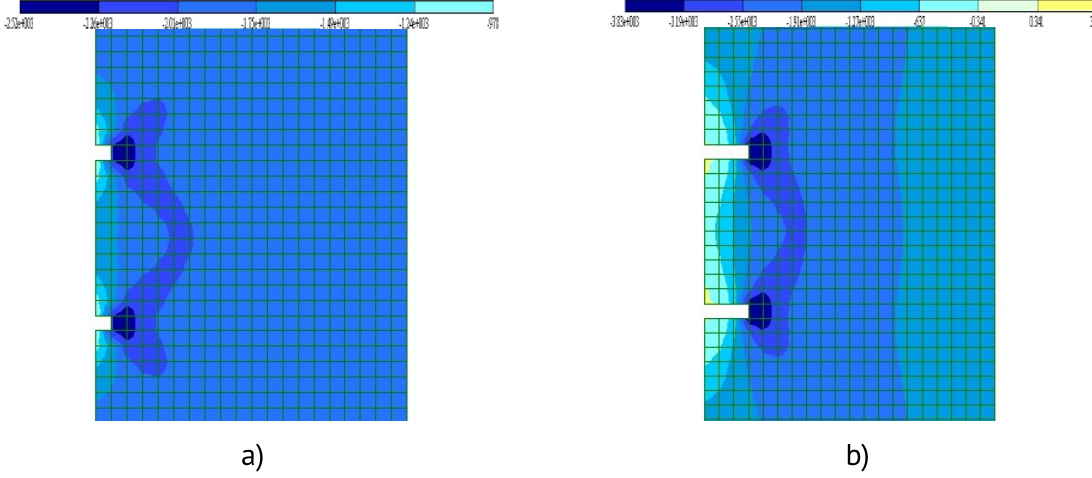
Figure 4. Stress fields Ny in the area with structural defect: defect depth 5 mm (а) and 15 mm (b) for concrete grade С12/15 under stress in